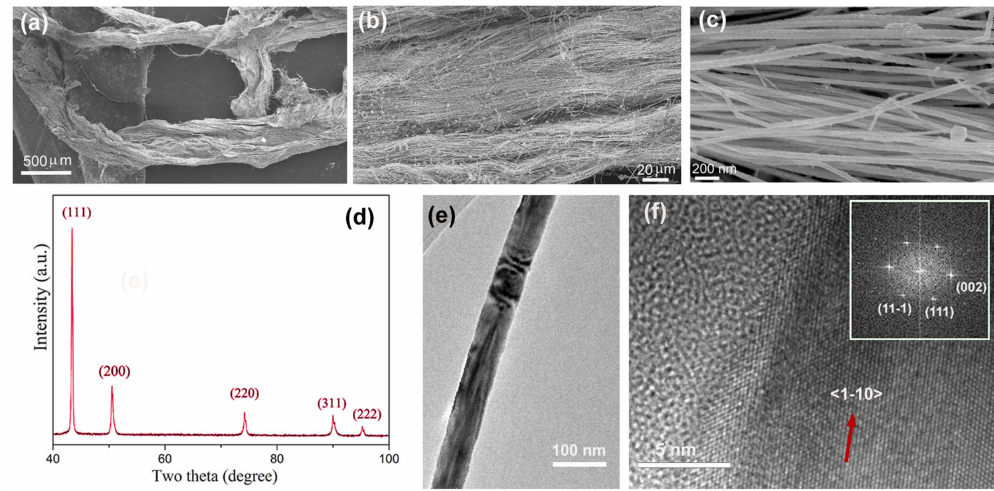
Figure 2. ( a – c ) SEM images at different magnifications of the product formed in the presence of oleylamine at 160 ◦ C for 96 h; ( d ) XRD patterns of the product; ( e , f ) transmission electron microscopy (TEM) images of a nanowire. Inset of Figure 2f is the corresponding reduced fast Fourier transform